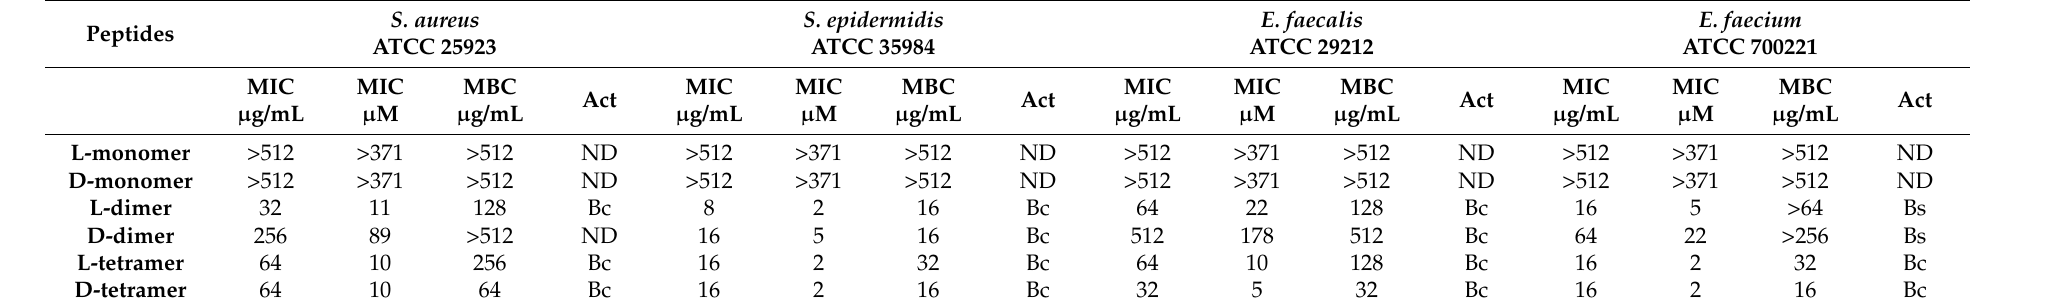
Table 1. Minimal inhibitory, bactericidal concentration and antibacterial activity of p-BthTX-I analogs against Gram-positive bacteria.